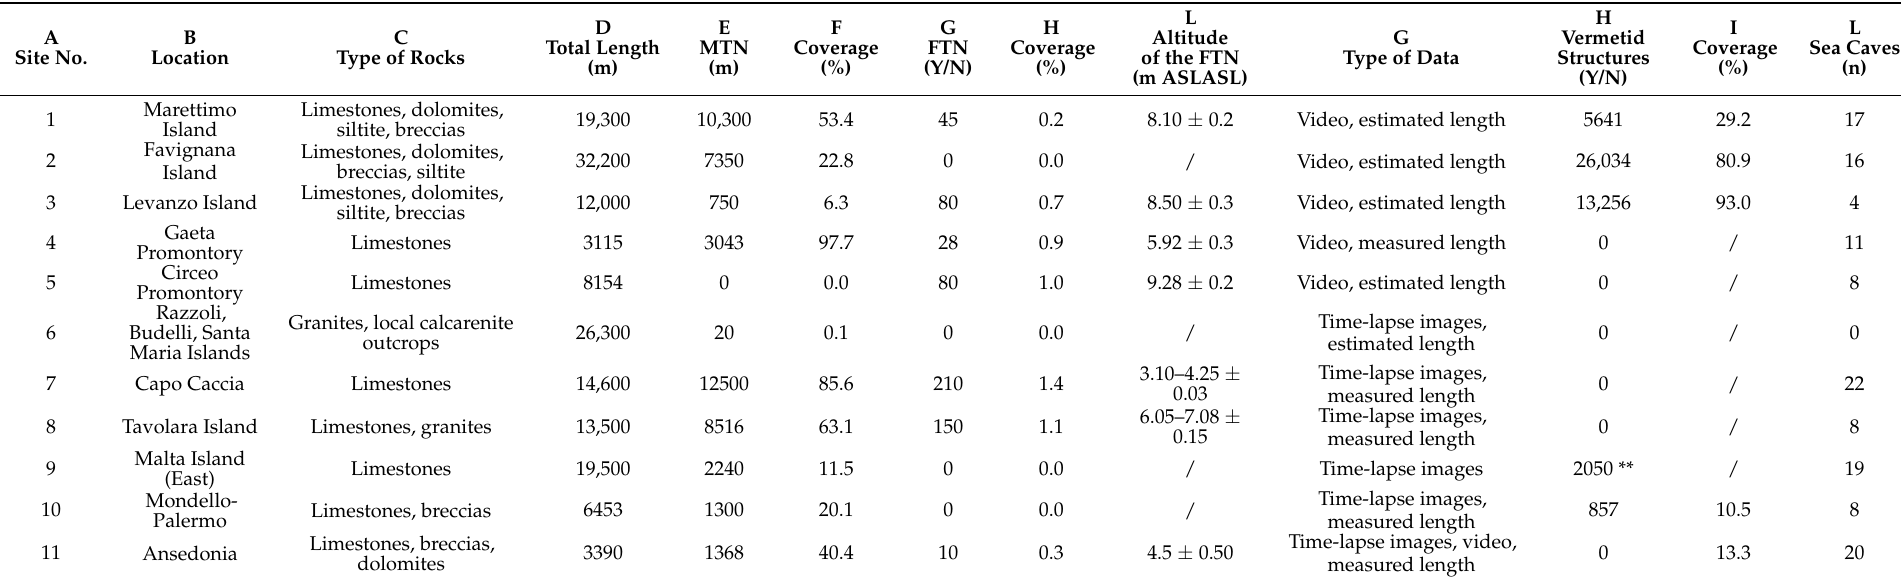
Table 2. Extent and altitude ASLASL of sea level change markers studied during the field